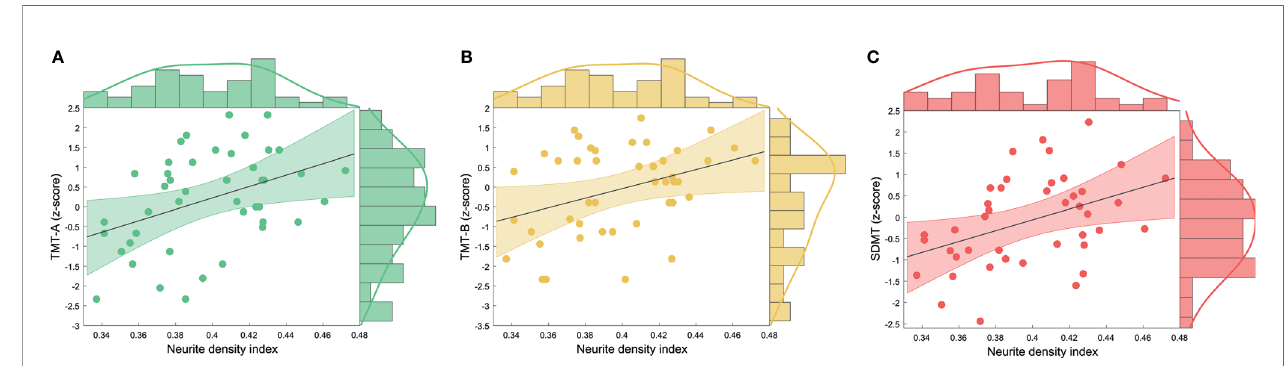
FIGURE 3 | Scatterplot with regression line and density estimates of the regression of (A) TMT-A, (B) TMT-B and (C) SDMT z-scores on neurite density index in patients with MS. MS, multiple sclerosis, TMT-A, Trail Making Test part A, TMT-B, Trail Making Test part B, SDMT, Symbol Digit